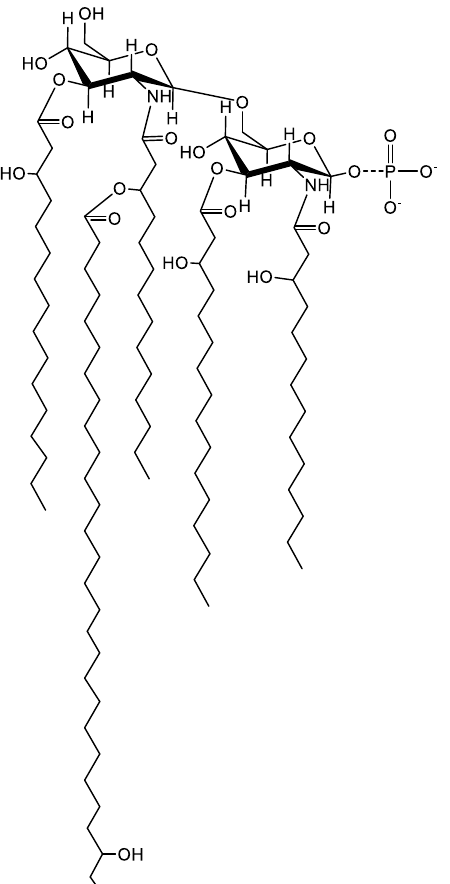
Figure 11. Proposed structure for the major species of Lipid A released from Lcr LPS. The major ion in the positive mode MALDI spectra is a pentaacylated GlcN disaccharide backbone with two amide-linked 14:0 (3-OH) residues, two ester-linked 16:0 (3-OH) residues, and one 27-hydroxyoctacosanoic acid linked as an acyloxyacyl residue. It is possible the lack of phosphate in the major ion is an artifact of the mild acid hydrolysis used for lipid A release and that the native structure is a 1-monophosphoryl species.